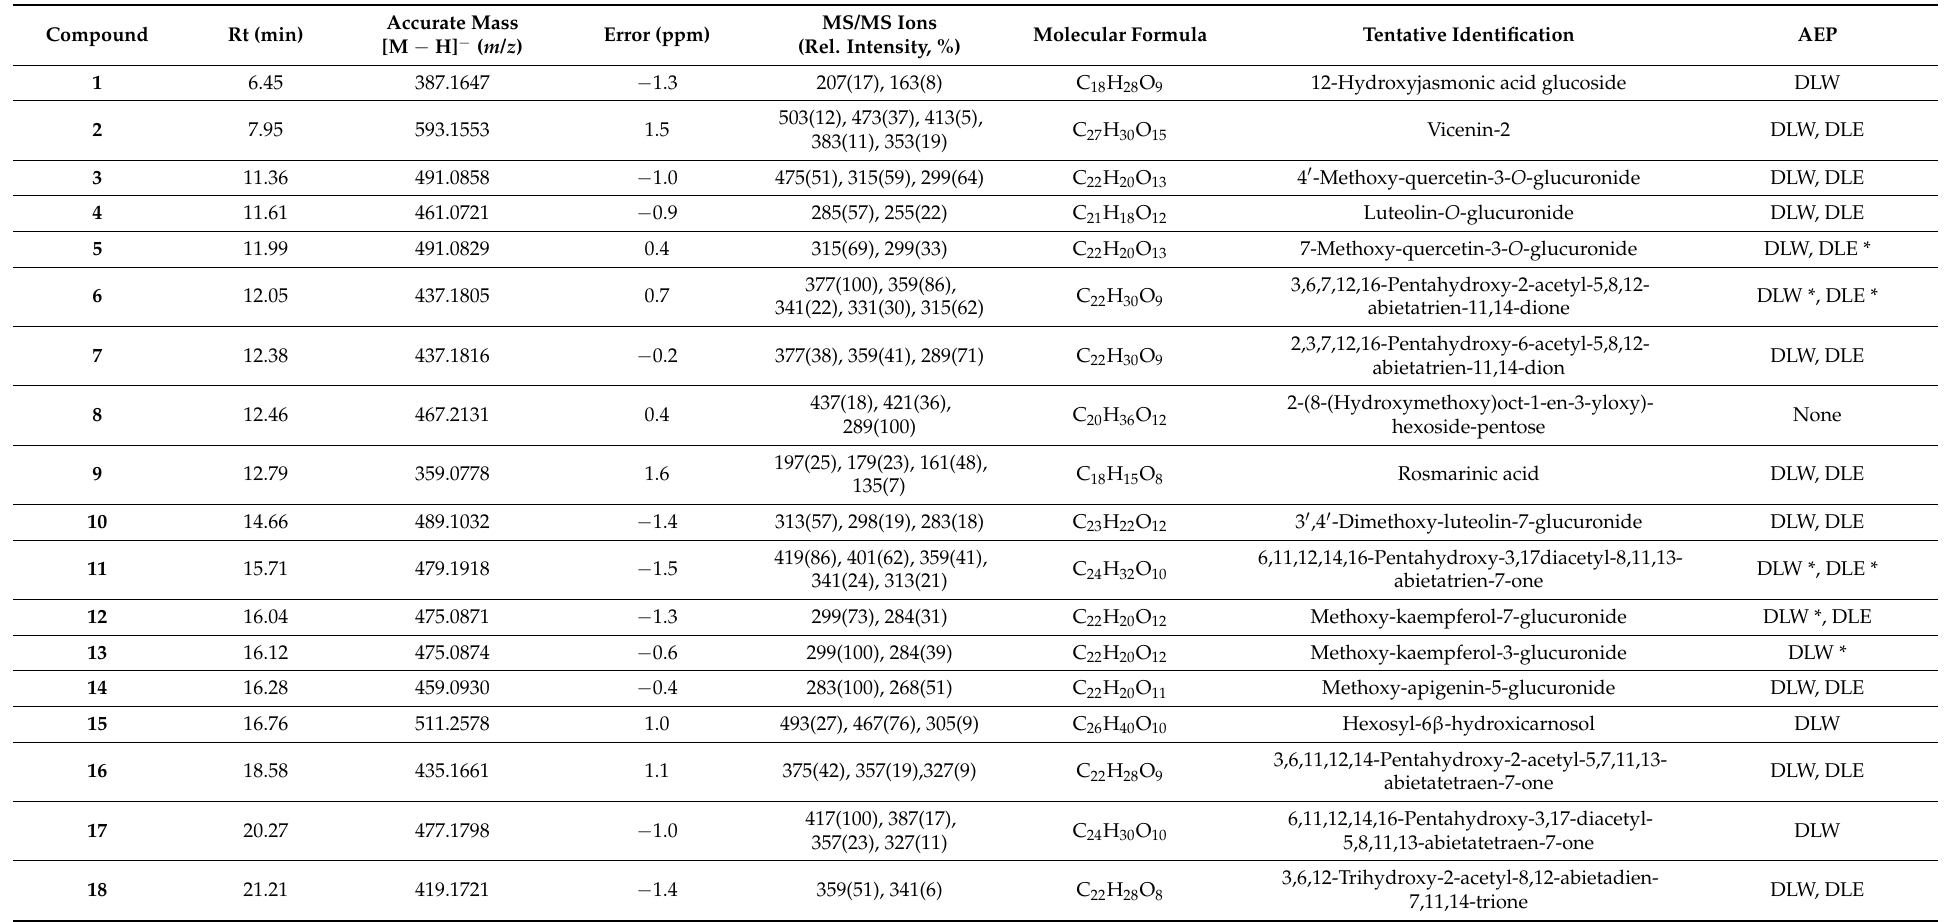
Table 3. Assigned compounds, [M − H] − and ESI negative fragment ions of the eighteen peaks detected in Plectranthus neochilus fresh leaves decoction (FLD)